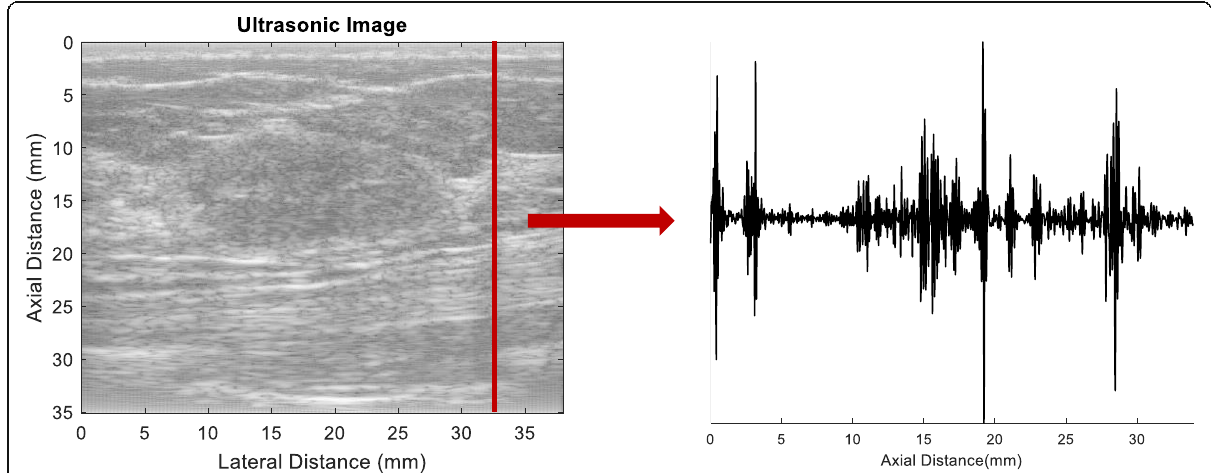
Fig. 7 A representative US image [56] and a raw US signal extracted from one of the image lines. The US image is formed using the log- compressed envelope of the raw US signals of each line